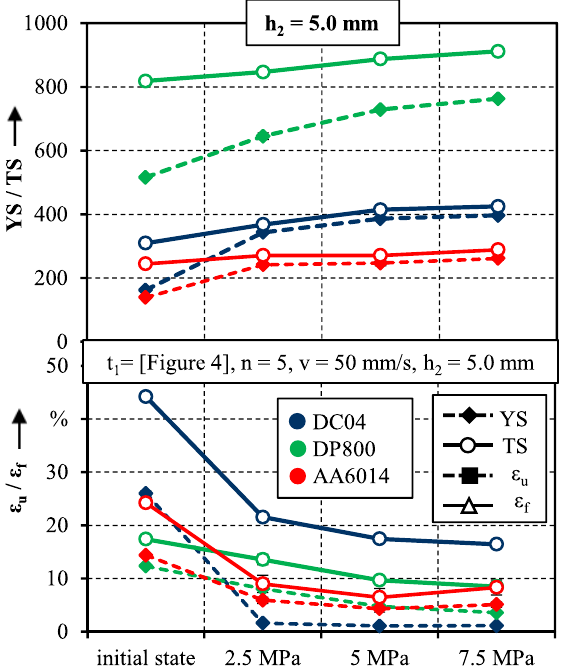
Fig. 8. Tensile test parameters after a drawbead h 2 with variation of the blankholder pressure between p N =2.5MPa and 7.5 MPa ( h 2 =5.0 mm, v =50 mm/s).